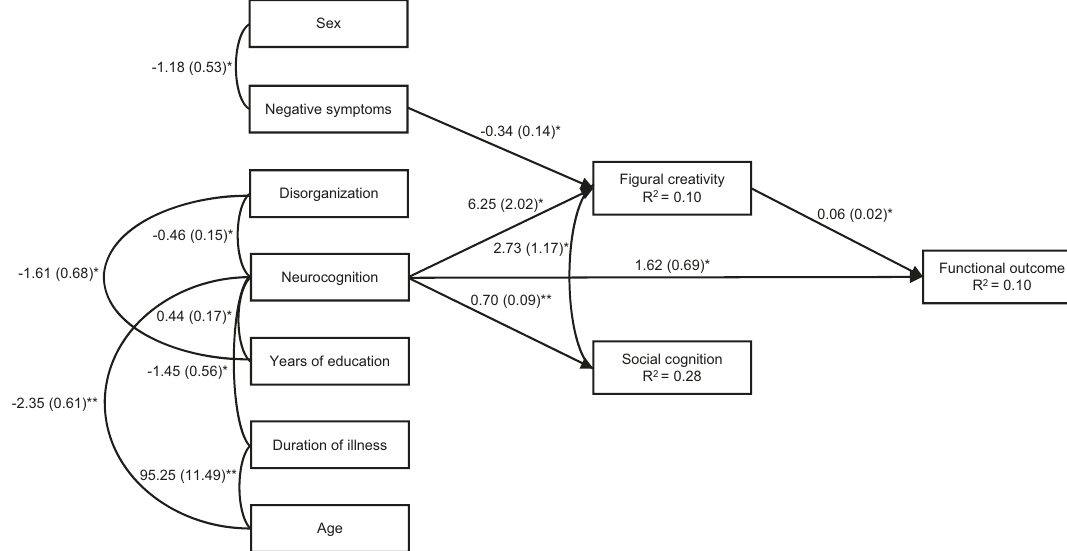
Fig. 1 Model of mediation explaining functional outcome through negative symptoms, neurocognition, social cognition, and fi gural creativity. Given values are non-standardized coef fi cients with standard errors in parentheses. * p ≤ 0.05; ** p ≤